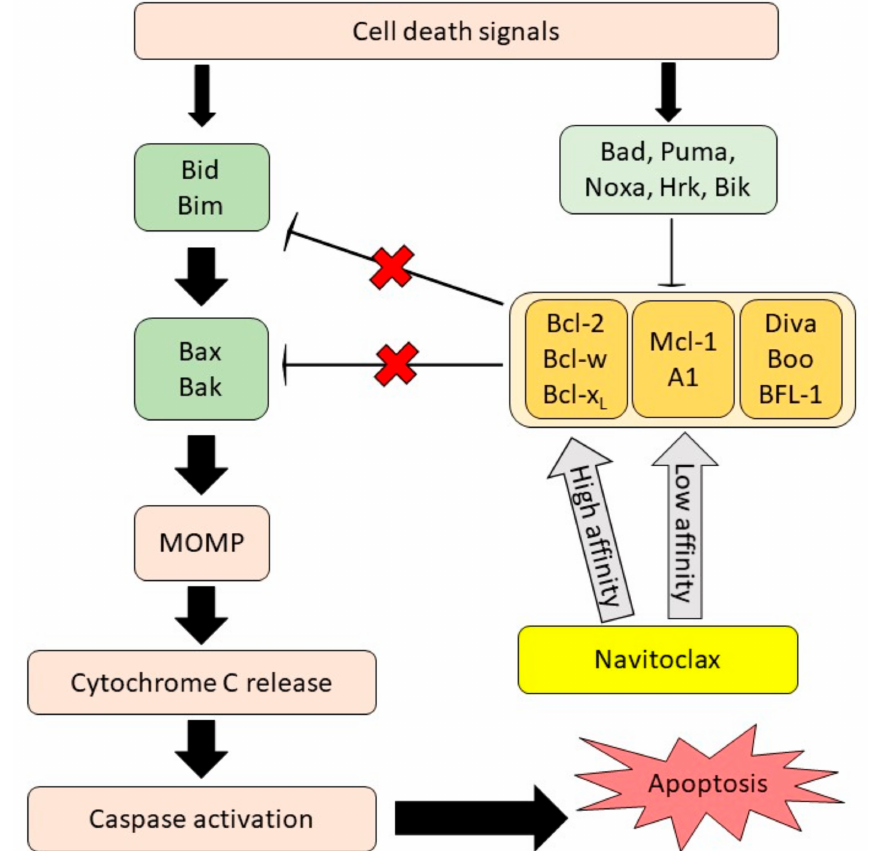
Figure 1. Navitoclax mechanism of action. Navitoclax potentiates the intrinsic cell death mecha- nism through the inhibition of anti-apoptotic proteins signal. Navitoclax affinity on anti-apoptotic proteins is varied. MOMP, mitochondrial outer membrane permeabilization, reproduced from